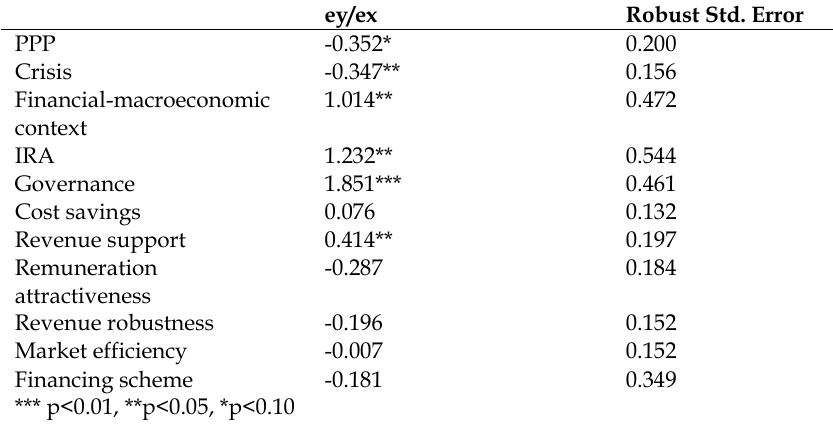
Table 3. Elasticities of cost and time underrun. ey/ex Robust Std. Error